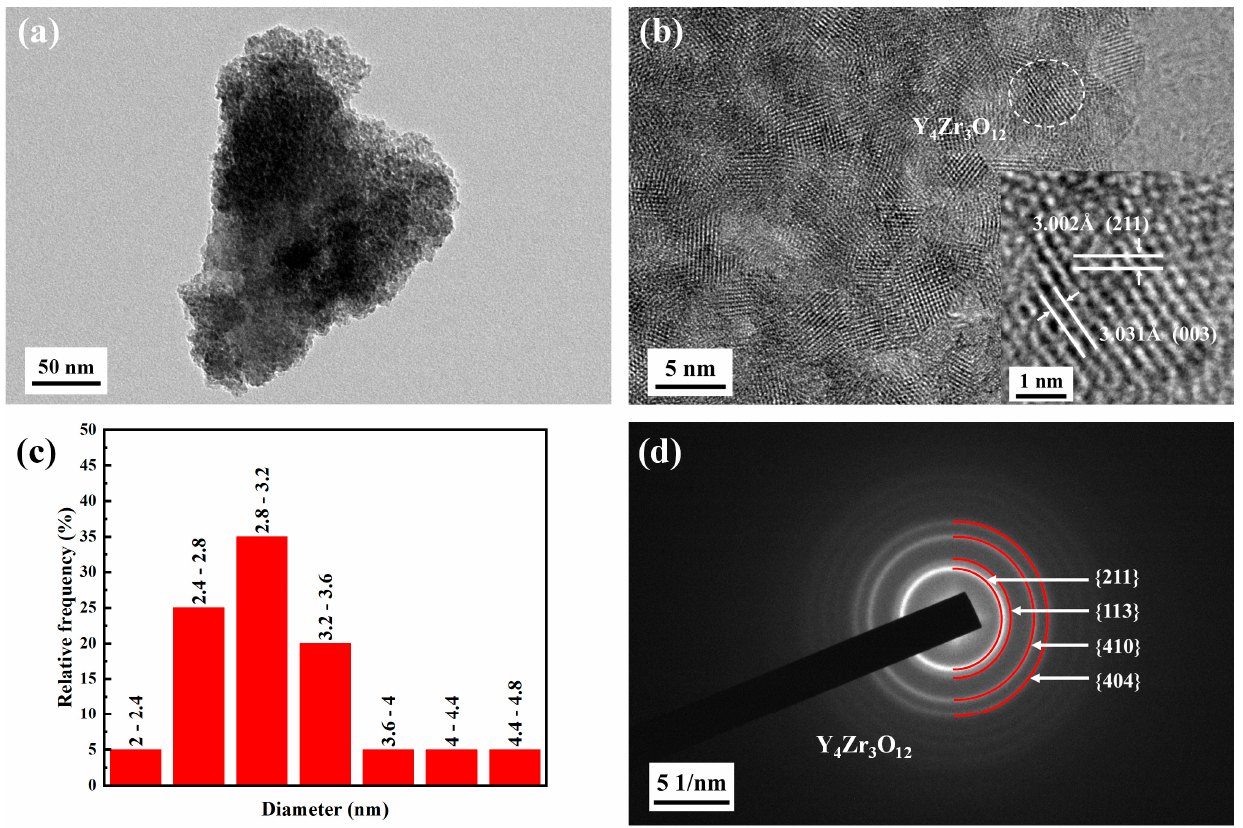
Figure 4. XRD patterns of the Y 4 Zr 3 O 12 powders calcined at different temperatures.